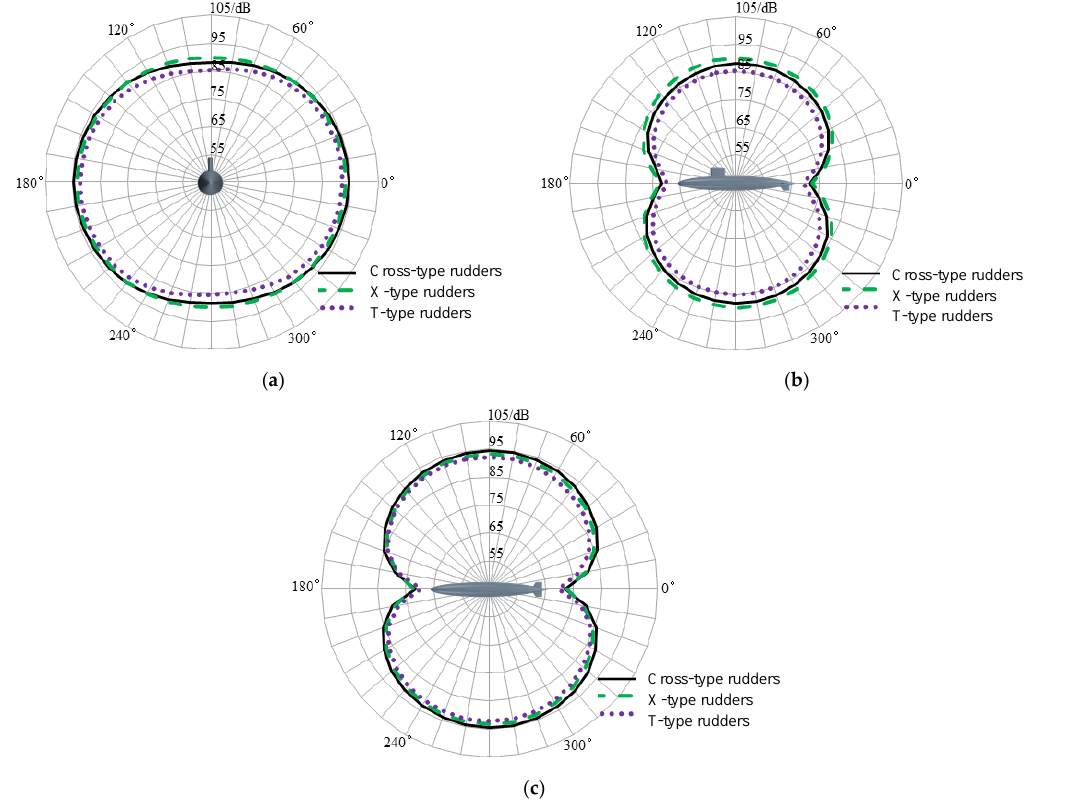
Figure 18. Directivity of sound pressure levels at different sections of the underwater vehicle with full appendages: ( a ) transverse cross-sectional directivity; ( b ) longitudinal section directivity; ( c ) horizontal section directivity.